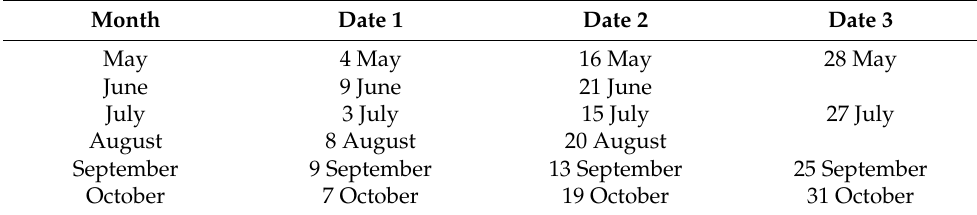
Table 3. Sentinel1 observation dates (2019) used for computing the coefficient of